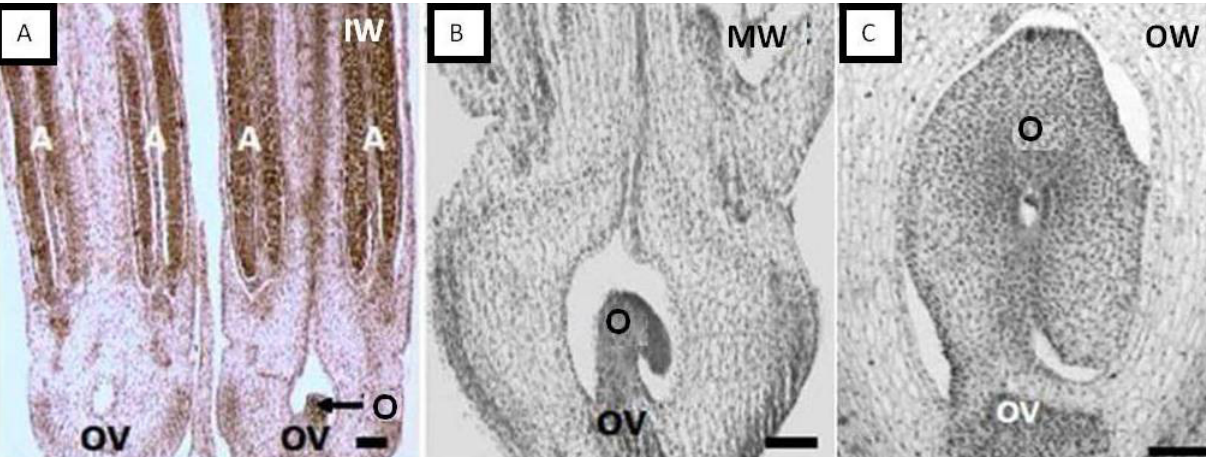
Fig. 9. Ovules at different development stages in hermaphrodite florets located on the same capitulum in H. annuus (in longitudinal sections). A. In inner whorl, floret without an ovule and floret with an ovule; B. In medial whorl, floret with an ovule starting to curve; C. In outer whorl, floret with fully developed anatropous ovule with an embryo sac. A: Anther; IW: Inner whorl floret; MW: Medial whorl floret; O: Ovule; OV: Ovarium; OW: Outer whorl floret. Bar: 100